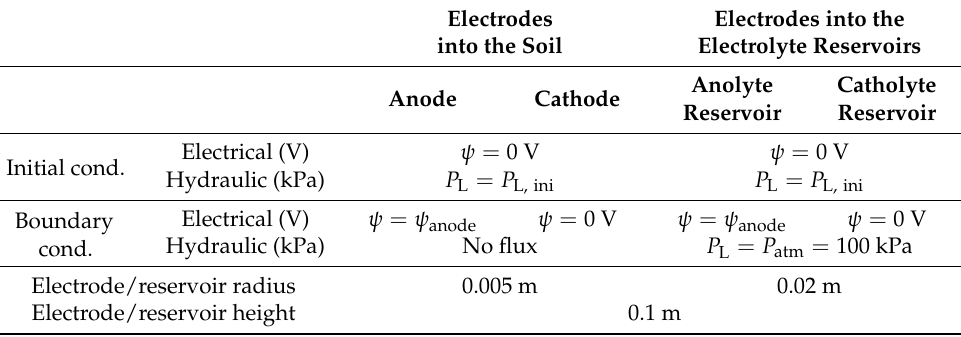
Table 2. Initial and boundary